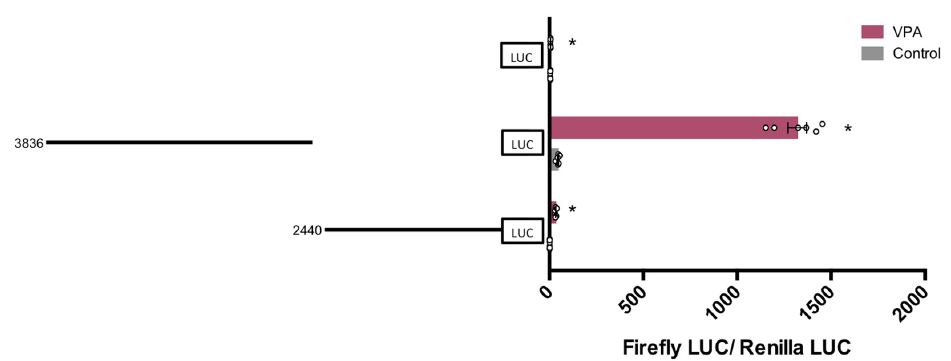
Figure 3. Response of two putative hVDR (human Vitamin D Receptor) gene promoter regions of 3836 bp and 2440 bp to VPA (valproic acid). HepG2 cells were transfected with the pGL4-VDR-3836 (sequence from − 1899 to +1937 around exon 1a transcription start site), pGL4-VDR-2440 (sequence from − 1253 to +1187 around exon 1c transcription start site), or pGL4 empty vector and treated with 5 mM VPA, or vehicle. Firefly luciferase activity was normalized with Renilla luciferase activity (relative light units, RLUs). Results are expressed as mean ± SEM from six independent experiments. * p -value < 0.05, t -test.